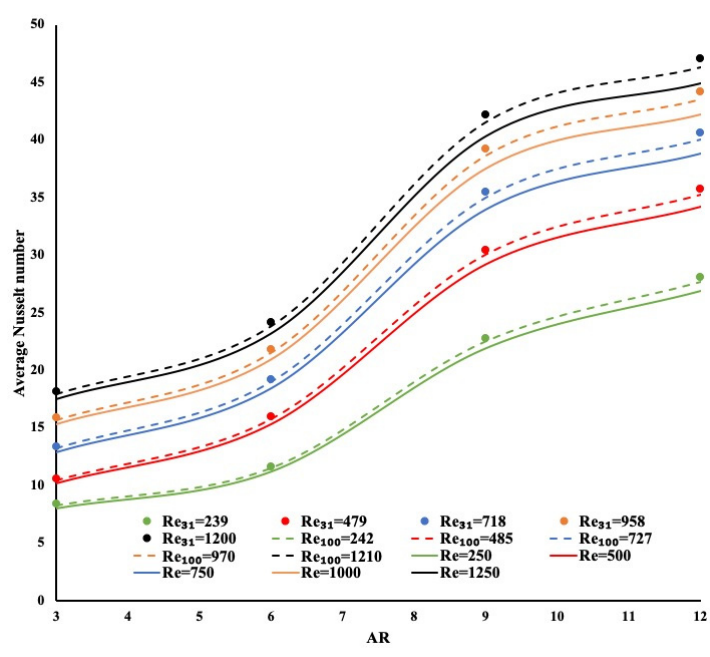
Figure 12. Average Nusselt number for all cases.